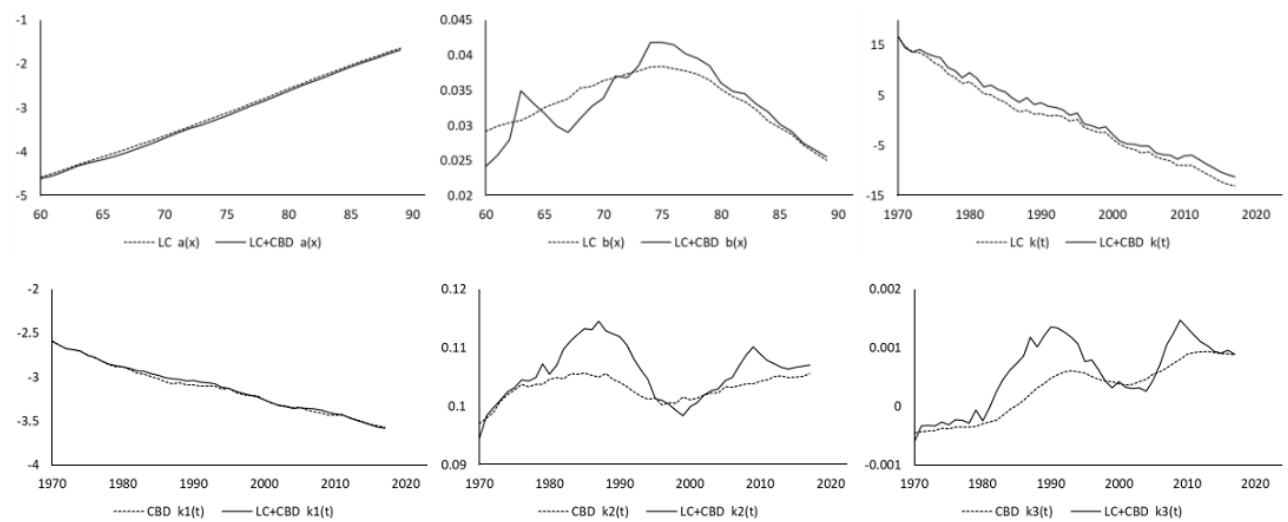
Figure 2. Posterior means of α ( x ) , β ( x ) , κ ( t ) , κ ( 1 ) ( t ) , κ ( 2 ) ( t ) , and κ ( 3 ) ( t ) from Bayesian Lee–Carter model (alone), CBD model (alone), and mixture model.